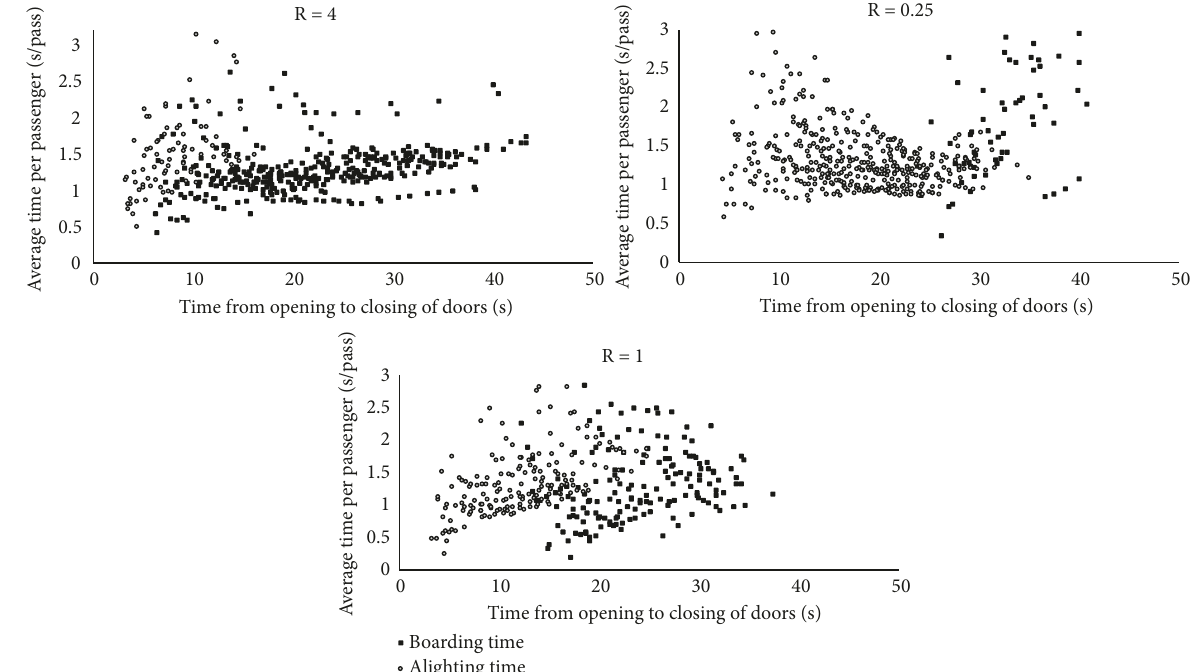
Figure6:Averageboardingtimeperpassengerj( 𝑡 𝑏𝑗 )andaveragealightingtimeperpassengeri (𝑡 𝑎𝑖 )atPAMELAwhennoncrowdedsituations are reached at the PTI.